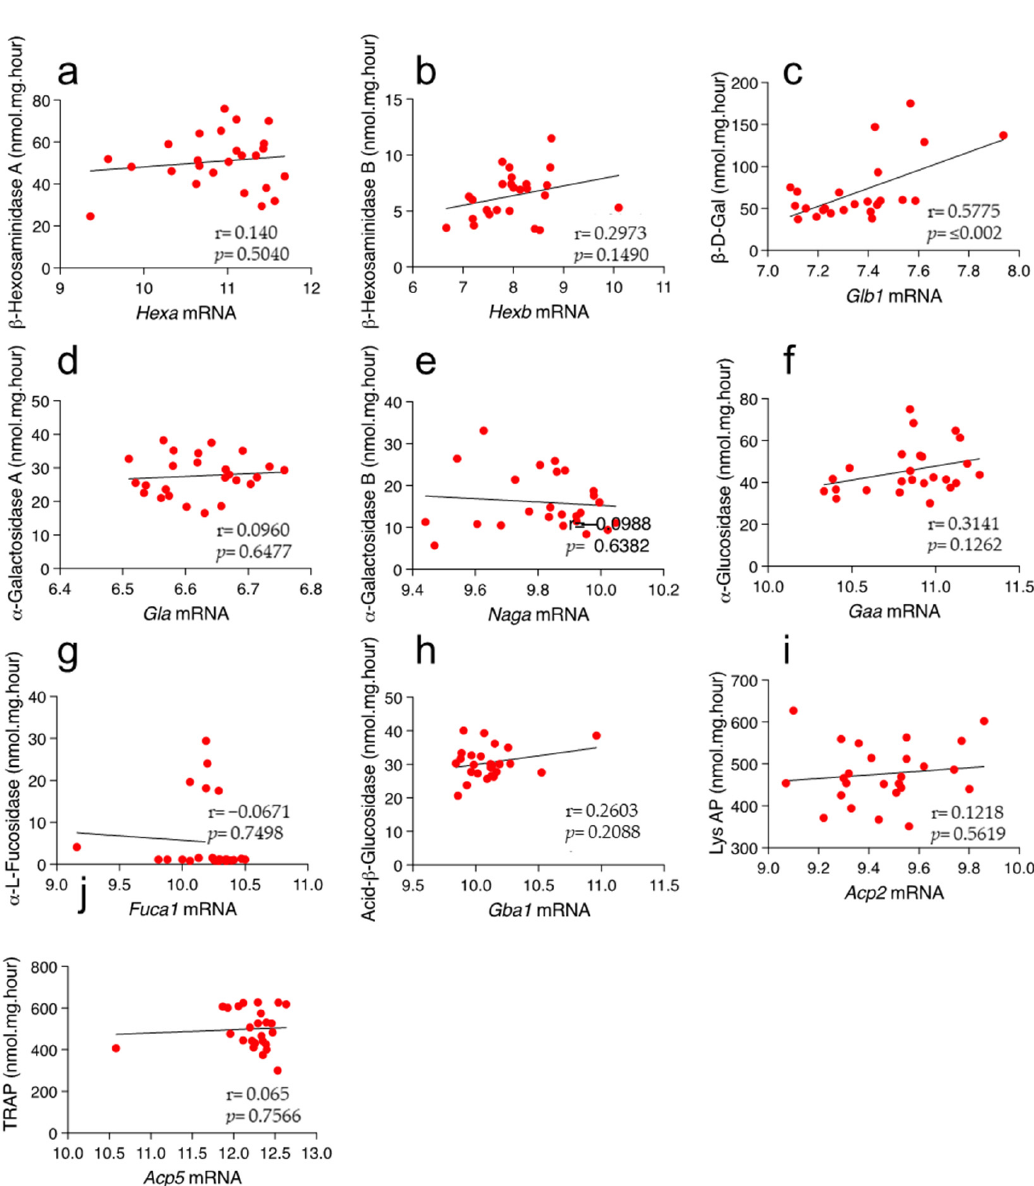
Figure 2. Correlation between expression levels and enzymatic activity in liver of mouse inbred strains. Each dot represents a mouse strain. ( a ) β -Hexosaminidase A. ( b ) β -Hexosaminidase B. ( c ) β - D-galactosidase. ( d ) α -galactosidase A. ( e ) α -galactosidase B. ( f ) α -Glucosidase. ( g ) α -L-Fucosidase. ( h ) Acid- β -glucosidase. ( i ) Lysosomal acid phosphatase. ( j ) Tartrate-resistant acid phosphatase. The Pearson’s correlation was performed using 23 strains of mice. Enzyme activities are expressed as nmol/mg/hour and mRNA levels, which were downloaded from repository GSE16780 UCLA Hy- brid MDP Liver Affy HT M430A [24] are expressed as log2 transformed. r, correlation; p , p -value.